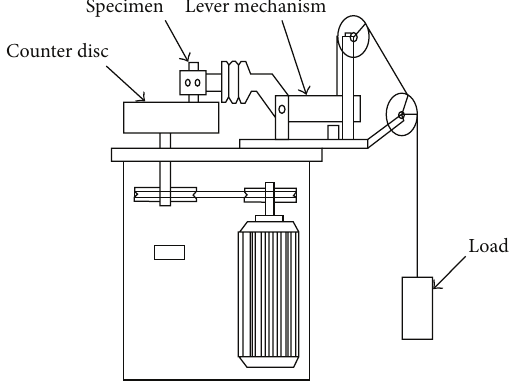
Figure 1: Schematic diagram of pin-on-disc